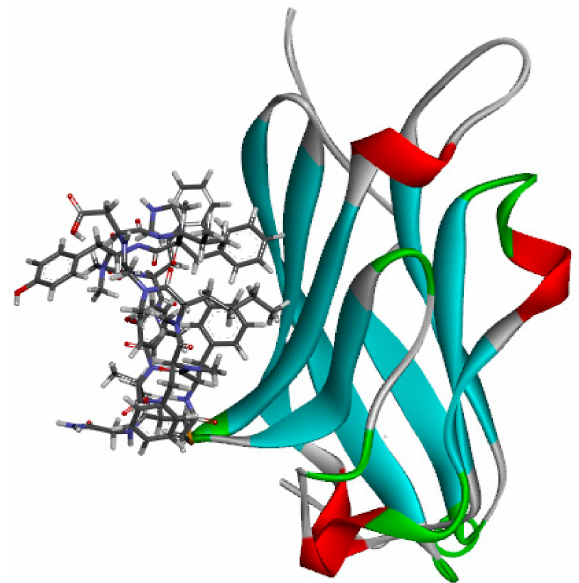
Figure 5. The crystal structure of peptide-71 and human programmed cell death ligand 1 (hPD-L1) (Protein Data Bank (PDB) ID: